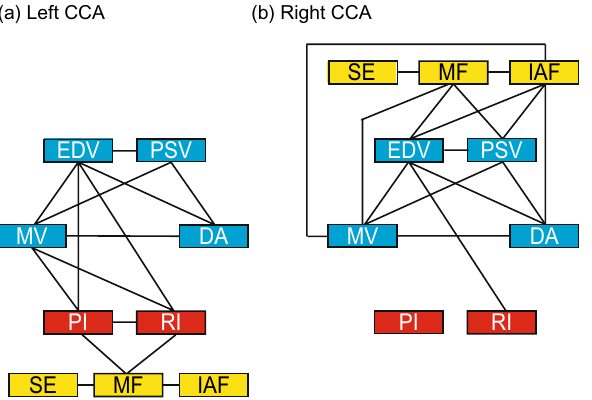
Figure 1. Schematic descriptions of relationships within/between ultrasonographic parameters and MEG spectral parameters. Lines represent a significant correlation. Blue, red, and yellow boxes represent local factors, downstream factors, and MEG spectral parameters, respectively. Biases in terms of patient age and sex were not considered in the relationships depicted here. CCA common carotid artery, D A diameter of artery, EDV end- diastolic velocity, IAF individual alpha frequency, MEG magnetoencepharography, MF median frequency, MV mean velocity, PI pulsatility index, PSV peak systolic flow velocity, RI resistance index, SE Shannon